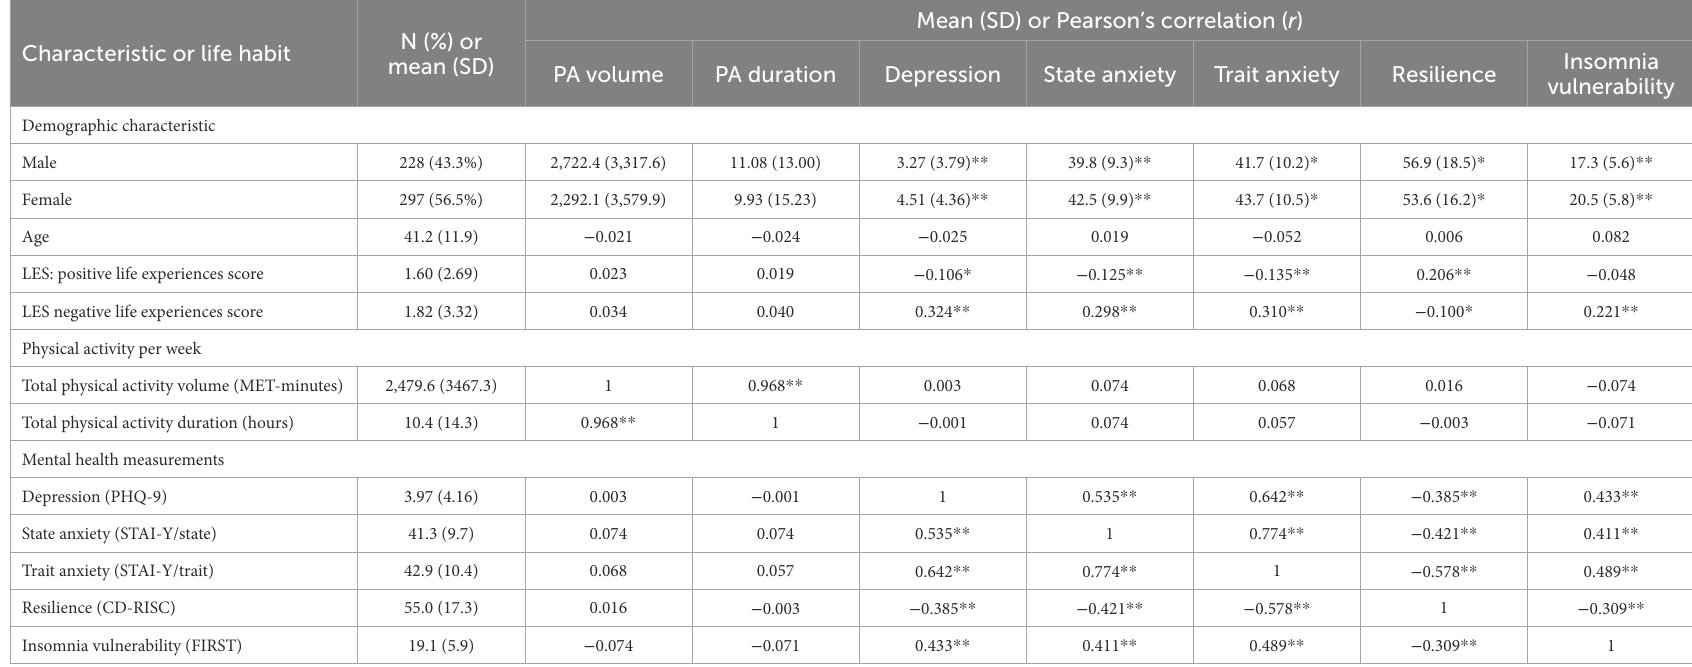
TABLE 1 Demographic characteristics, physical activity, and mental health measurements of the participants. Mean (SD) or Pearson’s correlation ( r ) N (%) or Characteristic or life habit mean (SD) PA volume PA duration Depression State anxiety Trait anxiety Resilience